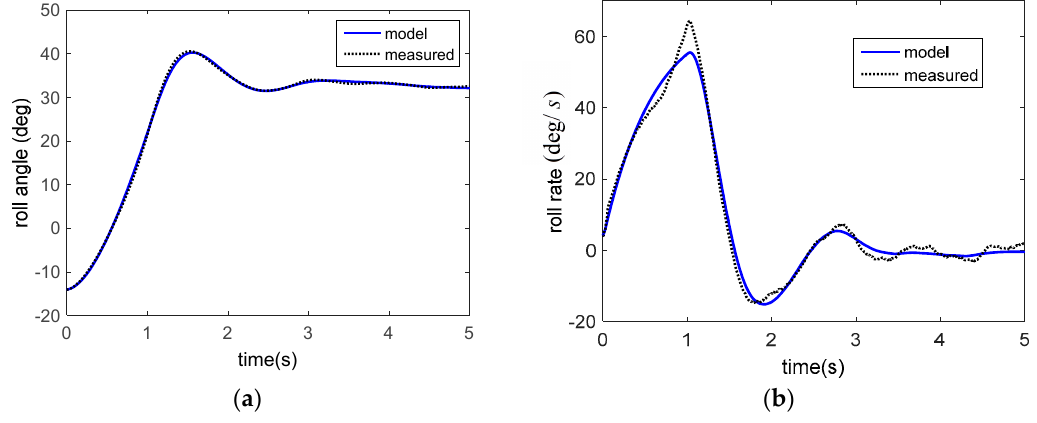
Figure 24. Open-loop model response versus measured data ( a ) Roll angle; ( b ) Roll rate. Table 2. Summary of the identified model parameters for each of the 8 wind tunnel step responses.